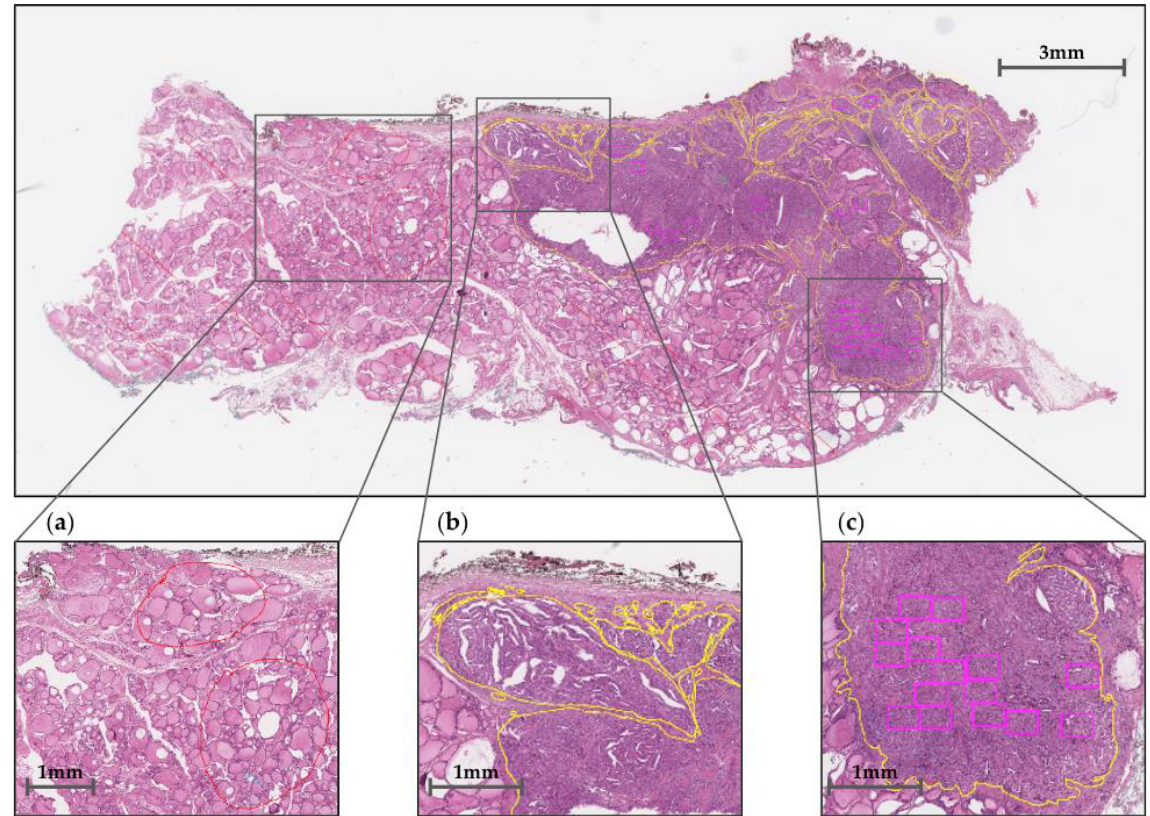
Figure 2. Whole-slide image (WSI) annotation: ( a ) normal regions, ( b ) tumor regions, and ( c ) TERT ROIs are marked in red and yellow contours and purple bounding boxes, respectively.